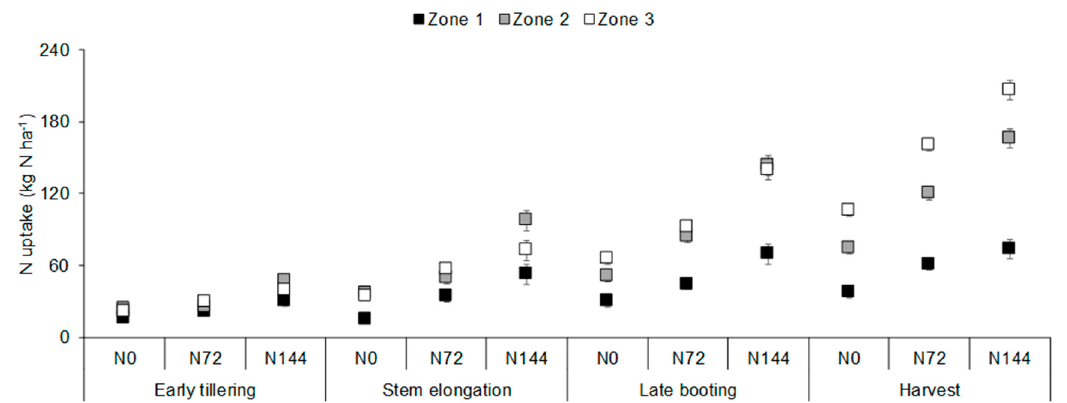
Figure 6. Mean N uptake values from the field trial presented separately by the time of monitoring survey, by nitrogen level (N0 = 0 kg N ha − 1 ; N72 = 72 kg N ha − 1 ; N144 = 144 kg N ha − 1 ) and by field zone (1, 2, and 3 representatives of low MZ1, medium MZ2, and high MZ3 grain yield, respectively). Error bars represent the standard error of the mean.